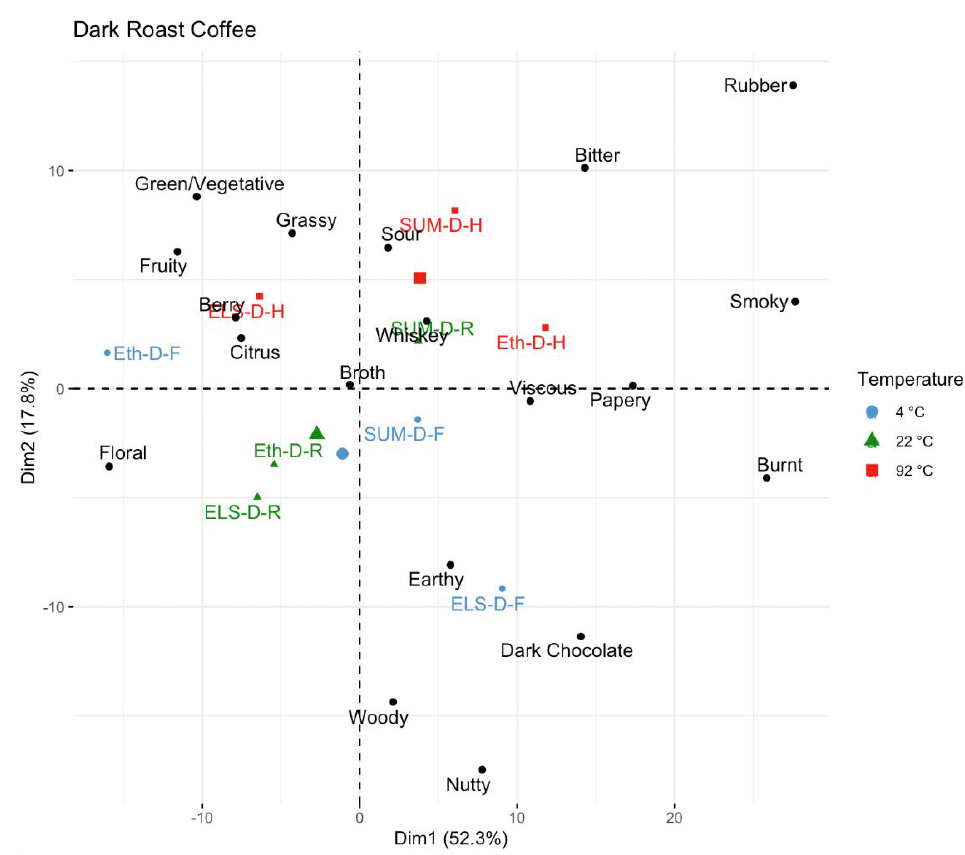
Figure 9. A principal component analysis of dark roast coffees, color-coded by brew temperature.